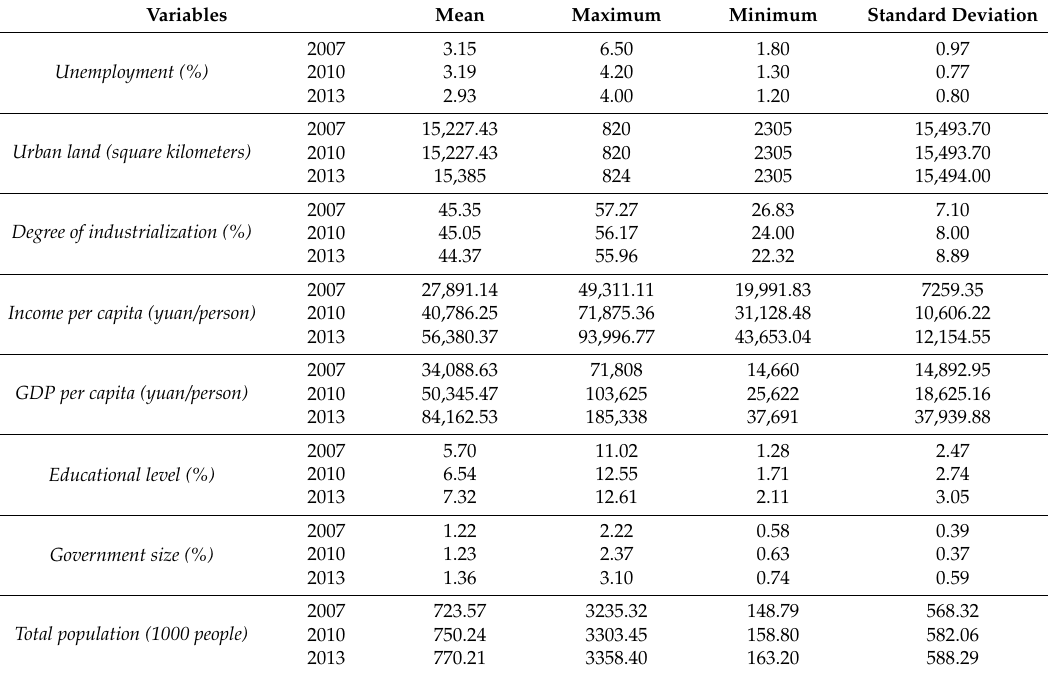
Table 4. Descriptive analysis of control